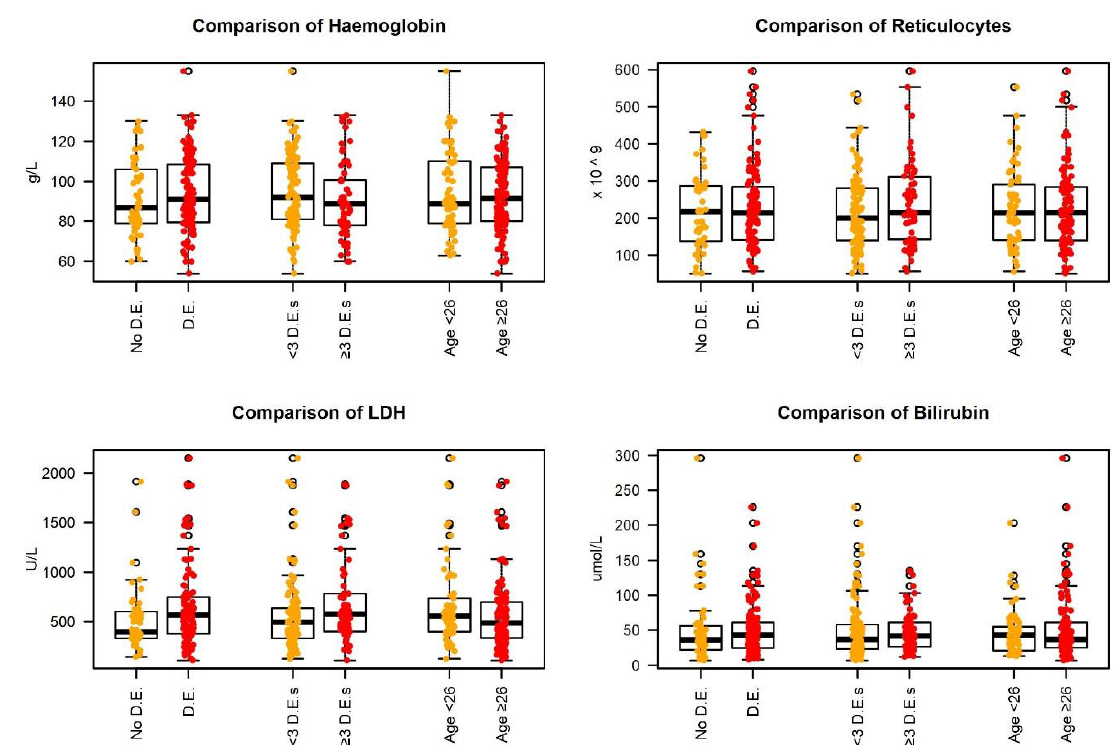
Figure 1. Correlation between dental extraction and haematological and haemolytic markers. D.E. is ‘Dental Extraction’, <3 and ≥ 3 refer to the number of extractions, and <26 and ≥ 26 refer to the age of the patient at their first extraction.